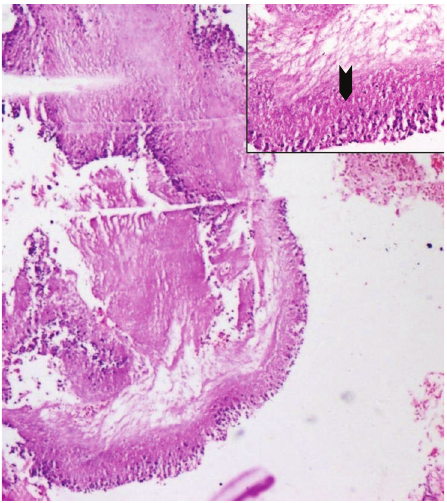
Figure 3: Splendore Hoeppeli phenomenon surrounding bacterial colonies with inflammatory cells (H&E, × 20) Inset, Splendore Hoeppeli phenomenon (arrow head) (H&E, × 40).